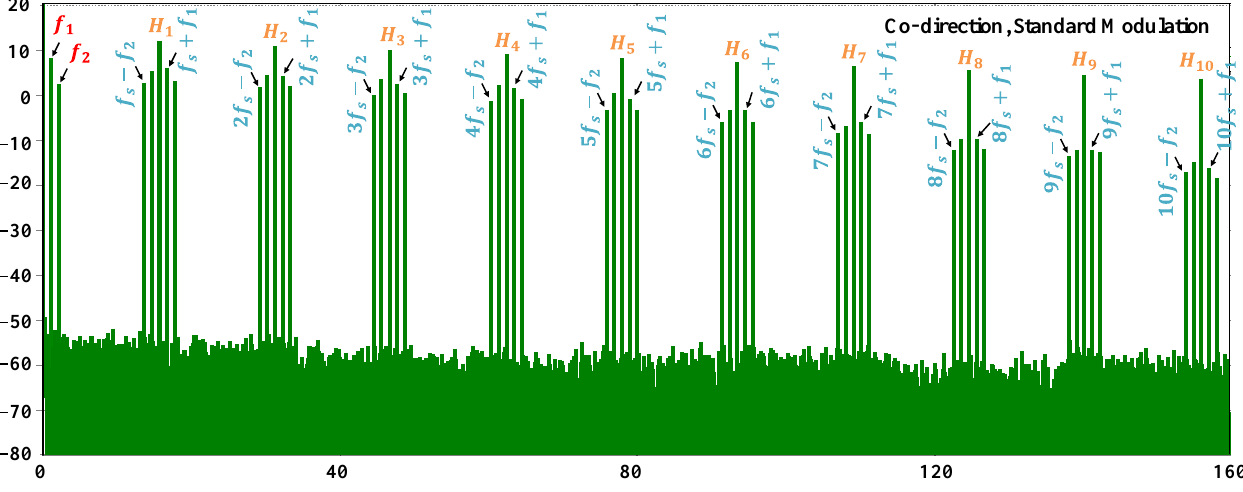
Figure 7. Electrical spectrum of the up-converted signal, which represents the electrical power in dBm as a function of frequency in GHz, at mixing frequencies 𝑛𝑓 𝑠 ± 𝑓 𝑚 at the SOA-MZI output for the standard modulation mode in the co-direction. The frequencies of the two input signals are 𝑓 1 = 1 GHz and 𝑓 2 = 2 GHz, the sampling frequency is 𝑓 𝑠 = 15.6 GHz and the harmonics of the sampling signal at 𝐻 𝑛 = 𝑛𝑓 𝑠 .